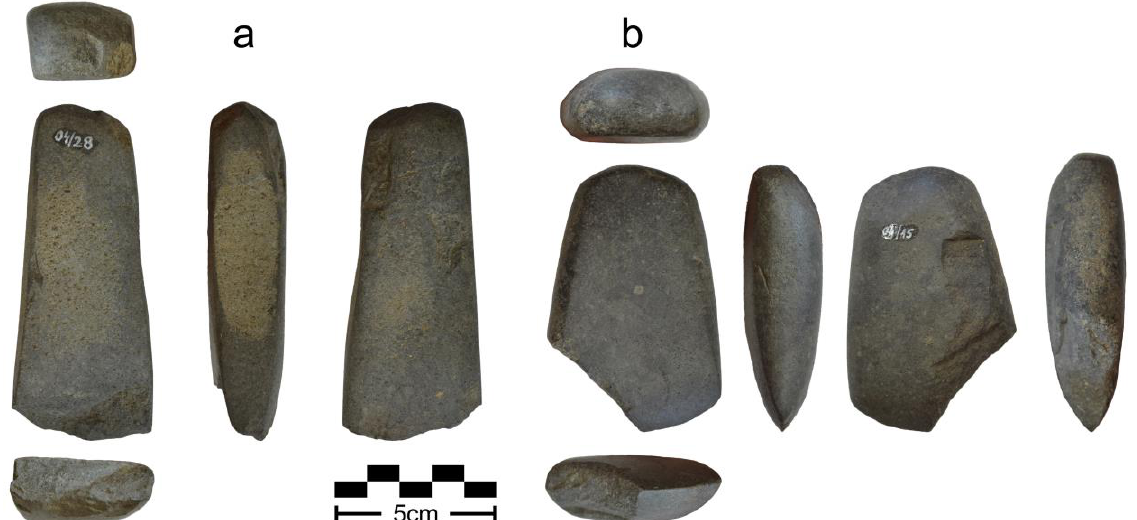
Figure 4. Examples of possible pick axe and chisel tools from Măgura ‘Buduiasca’. Grinding slabs and